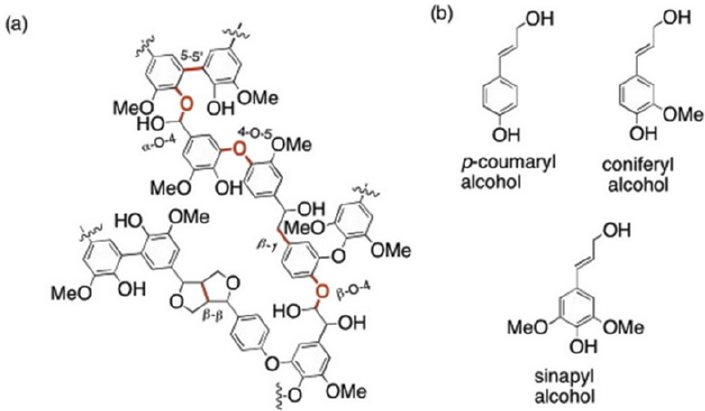
Figure 1. Chemical structure of lignin ( a ), and the main phenolic monomers ( b ). The obtained results [6] indicated that laser radiation at 532 nm acts on the aromatic rings with two OH-groups in lignin polymer; punctually, laser irradiation at 532 nm resulted in double bonds stretching (C=O and C=C) of aldehydes and ethenyl moieties in lignin monolignols, particularly reflected on the OH-groups in coniferyl alcohol. Moreover, studies have proved that laser effects occur in aqueous solvent only, and not in alcoholic or acetone solvents, and the laser power of 35 mW had no oxidative effects on the wood.